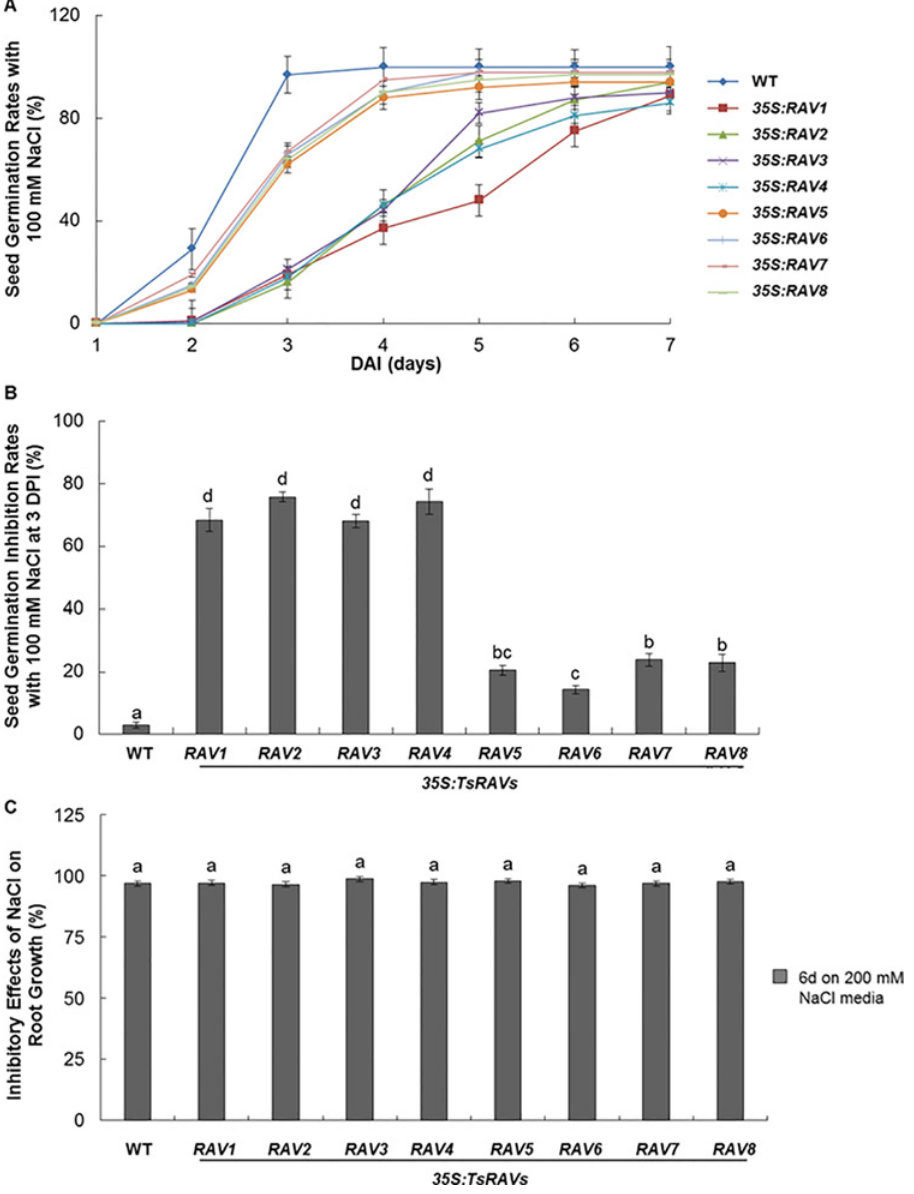
Fig 4. NaCl sensitivity of 35S : TsRAVs transgenic Arabidopsis plants. (A) Germination rates of 35S : TsRAVs transgenic Arabidopsis seeds on 1/2 MS media with 100 mM NaCl. Each data bar represents the means ± SE of three replicates. More than 100 seeds were measured in each replicate. (B) Inhibitory effect of 100 mM NaCl on 35S : TsRAVs transgenic Arabidopsis seed germination rates. Each data bar represents the mean ± SE of three replicates. More than 50 seedlings were measured in each replicate. Different letters indicate significant differences among means ( P < 0.05 by Tukey ’ s test). (C) Inhibitory effect of 200 mM NaCl on 35S : TsRAVs transgenic Arabidopsis seedling root elongation. Seedlings were grown on normal media for 5 days before being transferred onto 1/2 MS medium with 200 mM NaCl and grown for other 6 days. Each data bar represents the mean ± SE of three replicates. More than 50 seedlings were measured in each replicate. Different letters indicate significant differences among means ( P < 0.05 by Tukey ’ s